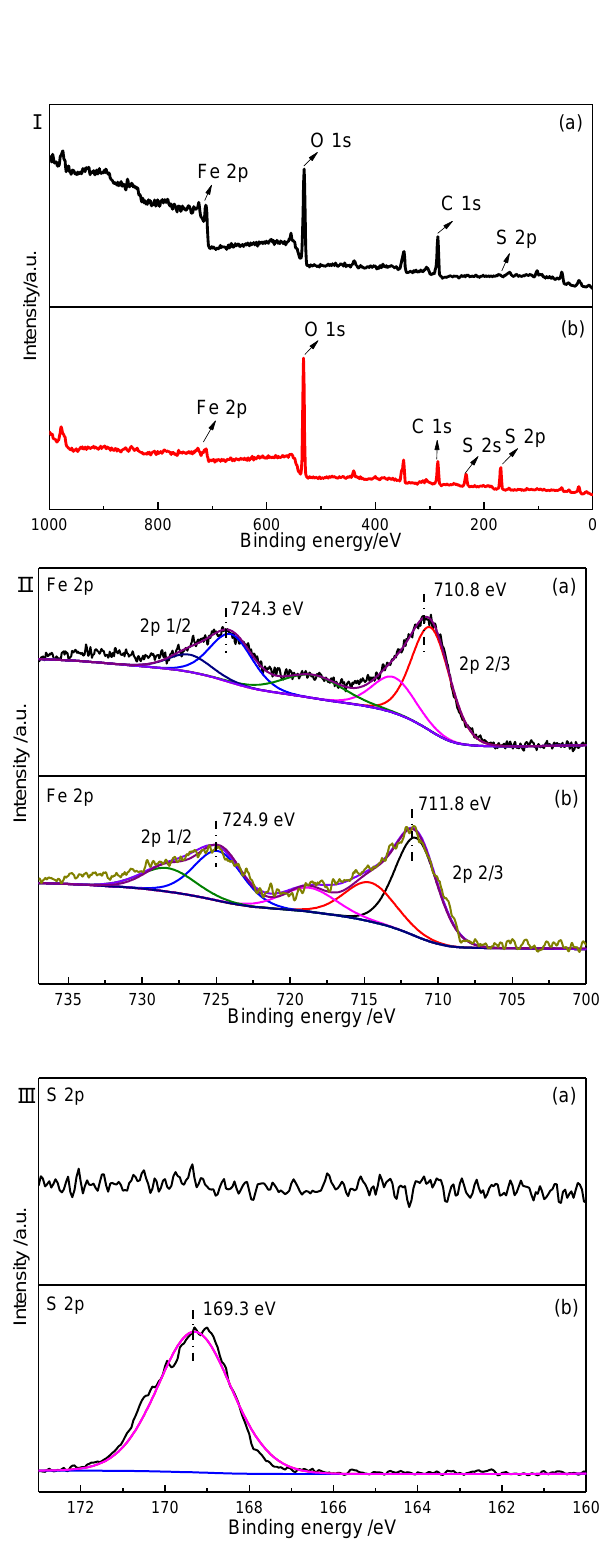
Figure 2. XPS spectra of the catalysts: SOC ( a ) and SSOC ( b ).